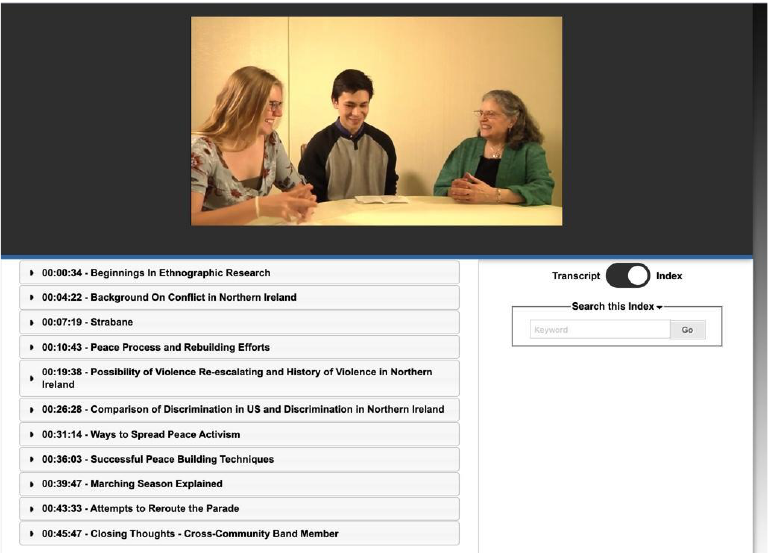
FIGURE 1. (FROM LEFT TO RIGHT) HERE, PAIGE WALTON AND JAKE KUTCHINS INTERVIEW DORIS PANZER. NOTE THE INDEX AT THE BOTTOM, THAT ALLOWS RESEARCHERS AN OVERVIEW OF THE